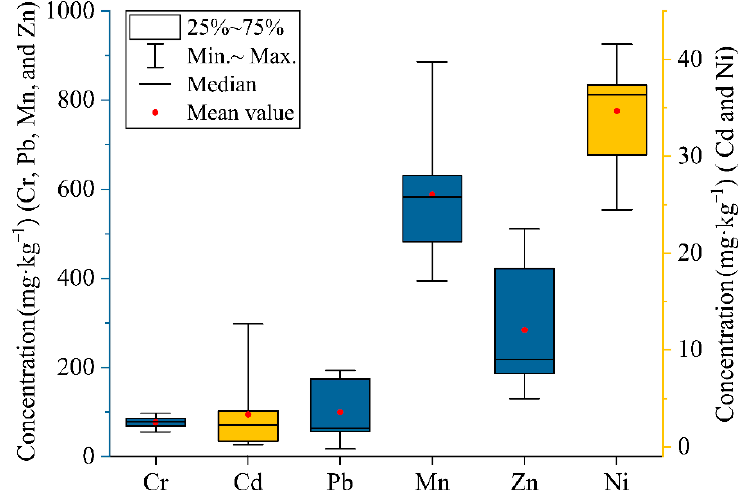
Figure 4. Boxplot of heavy metal concentration in the topsoil of the study area.